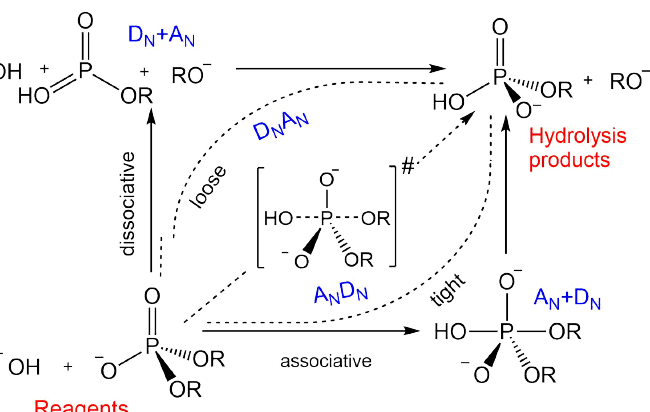
Figure 8. More O’Ferrall–Jencks diagram for the hydrolysis of phosphodiesters. Definition of the associative and dissociative